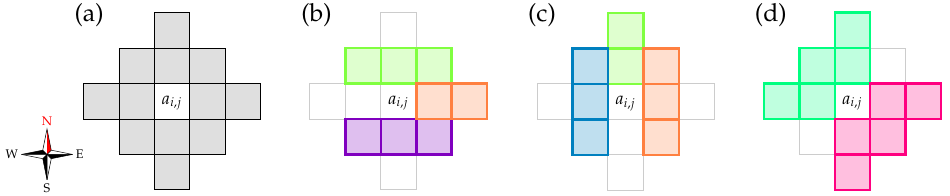
Figure 5. Neighbouring squares of a i , j used in the classification rules. ( a ) Full neighbourhood of a i , j ; the values of the statistics for the squares in it are used in at least one of the rules for the computation of e i , j . ( b ) Squares used in the rules for e 1 : eastern squares (orange), northern squares (green), and i , j southern squares (purple). ( c ) Squares used in the rules for e 2 : northern squares (green), eastern i , j squares (orange), and western squares (blue). ( d ) Squares used in the rules for e 3 and e 4 : the i , j i , j northwestern (respectively, southeastern) neighbourhood of a i , j is composed of the teal (respectively magenta) non-land squares that have the same distance from the coast as a i , j